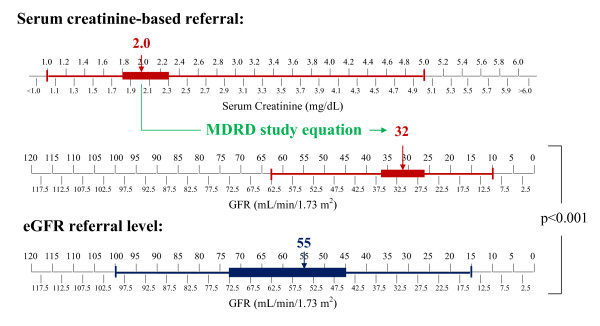
Recommended serum creatinine and estimated glomerular filtration rate (eGFR)-based referral levels by primary care providers. Note. Lines and bars represent the range and interquartile range of selected values, respectively. Abbreviations. eGFR, estimated glomerular filtration rate